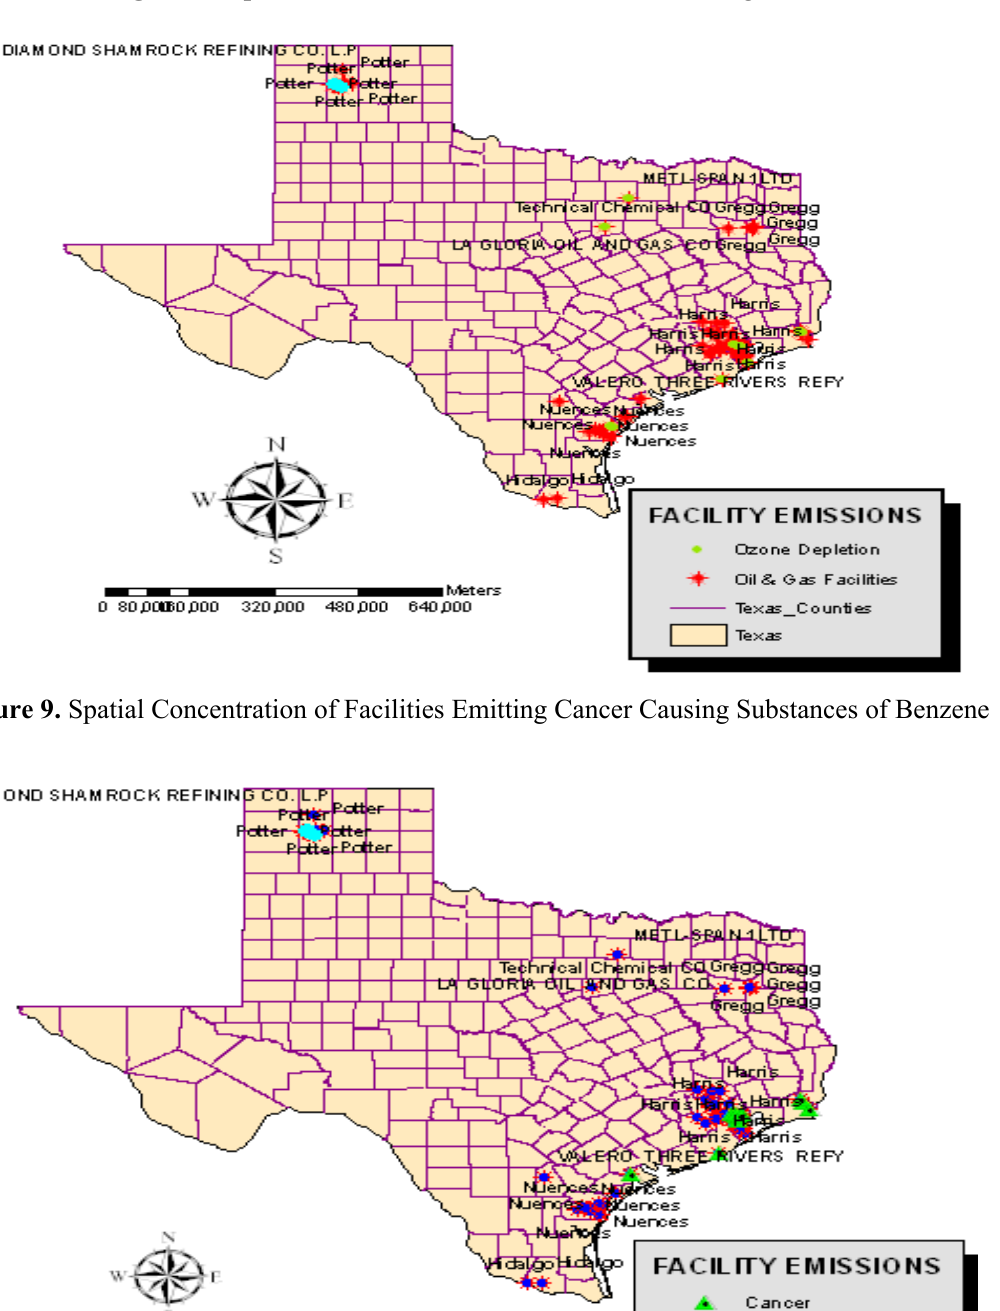
Figure 8. Spatial Distributions of Facilities Producing CFCs.